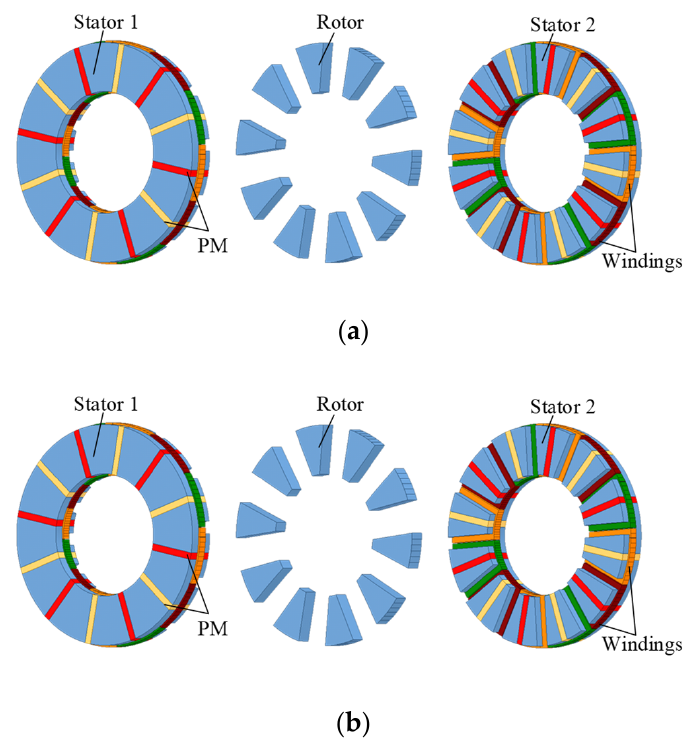
Figure 1. Topology of two AFFSPM machines. ( a ) AFFSPM machine with U-core stator segments; ( b ) AFFSPM machine with E-core stator segments.